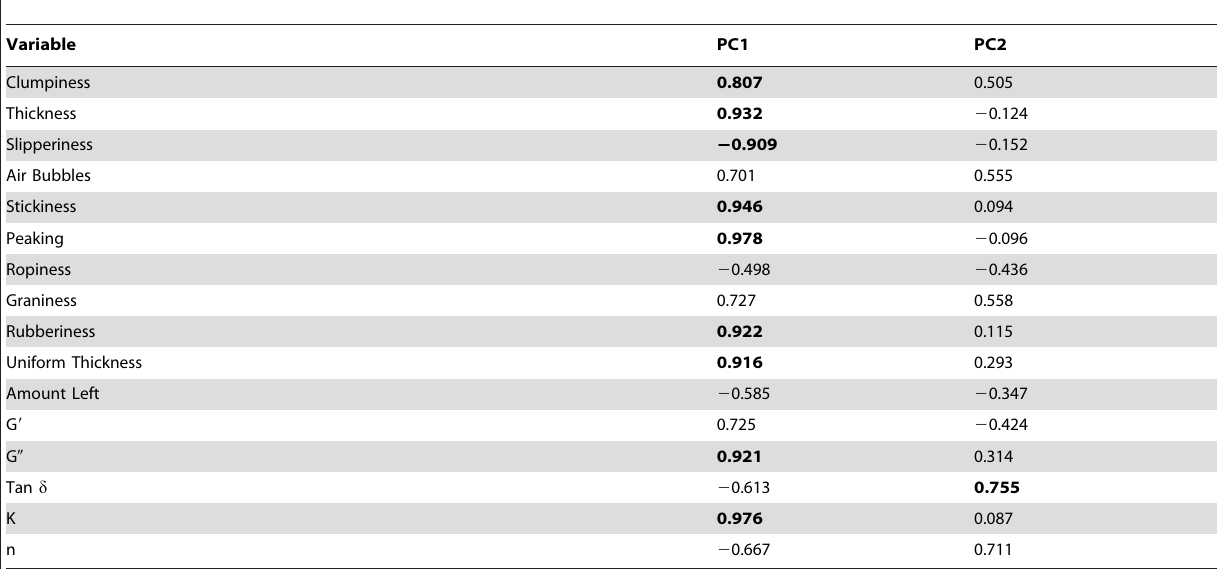
Table 1. MFA attribute loadings for sensory and rheological